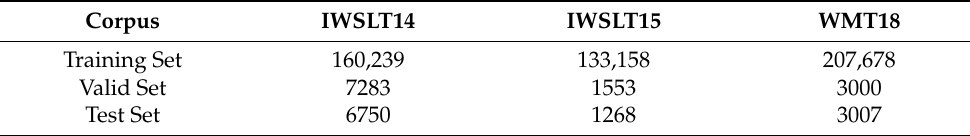
Table 1. Number of sentences in each